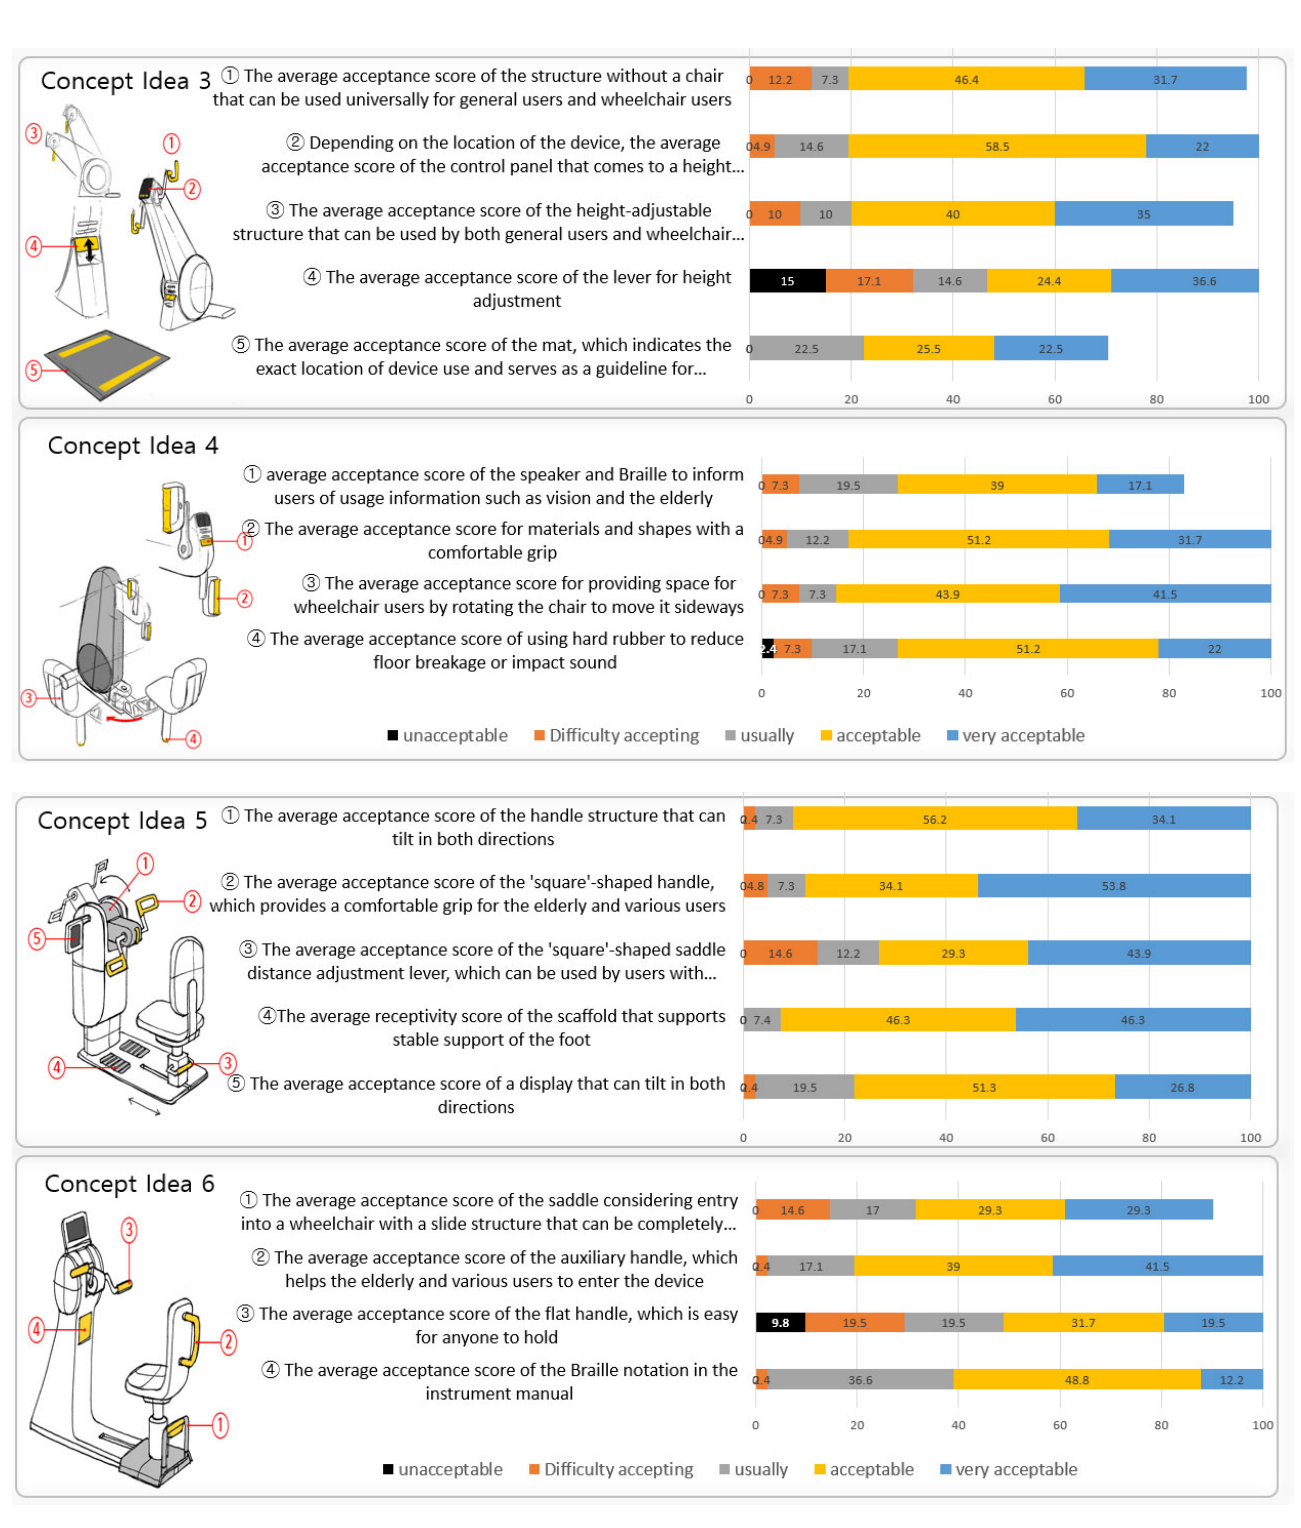
Figure 8. Concept idea of an arm ergometer applying